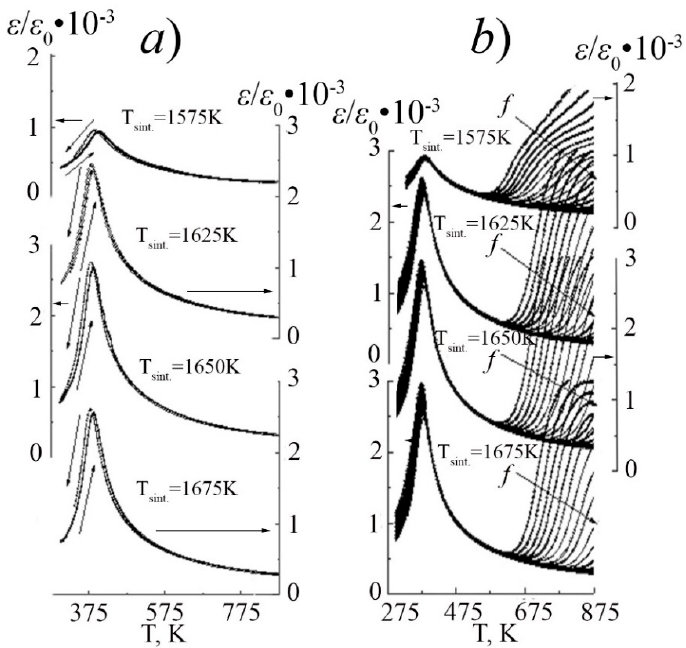
Figure 2. Dependencies of ε / ε 0 on T for SS Ba 0.5 Sr 0.5 Nb 2 O 6 , produced at different sintering temperature ( Т sint. ) ( a ) heat and cool, f = 1 kHz; ( b ) heat, ( f = 25 Hz ÷ 1 MHz).